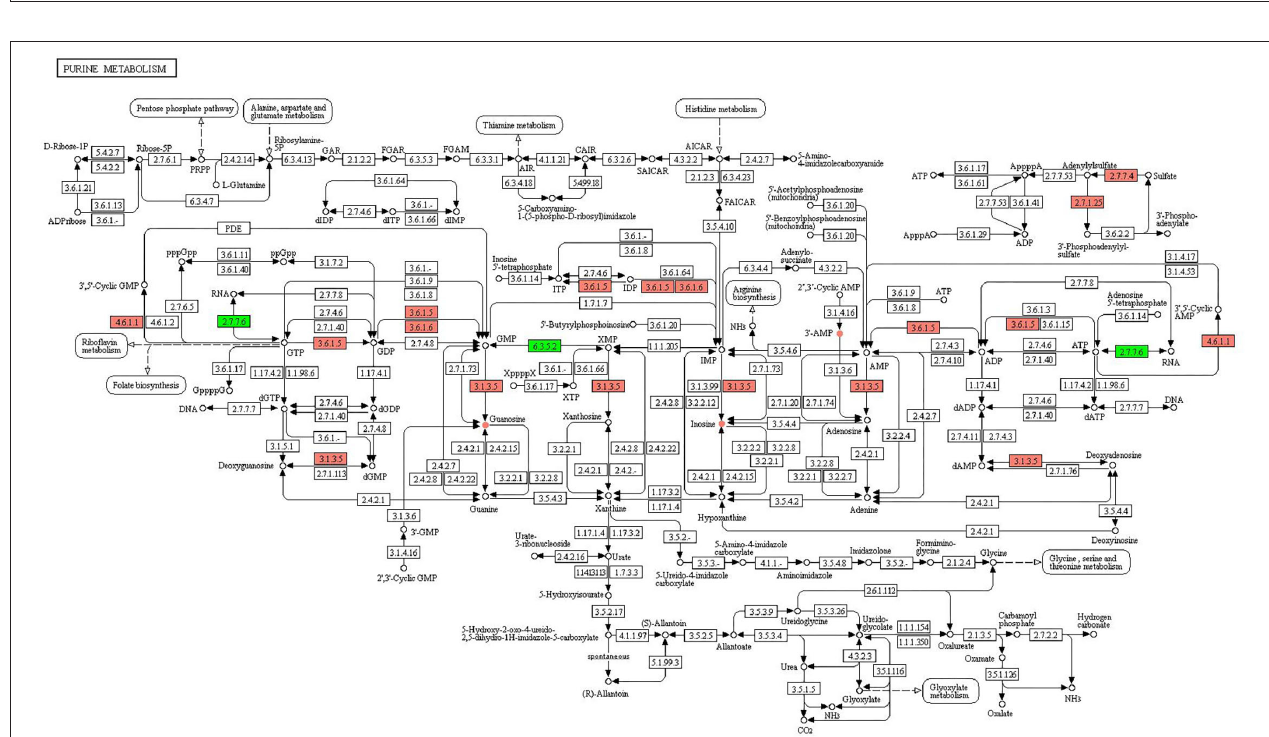
FIGURE 7 | KEGG pathway of purine metabolism. The boxes represent gene products, and the circles represent metabolites. The gene products in red and green are the upregulated and downregulated genes, respectively. The metabolites in red and green are the upregulated and downregulated metabolites, respectively.